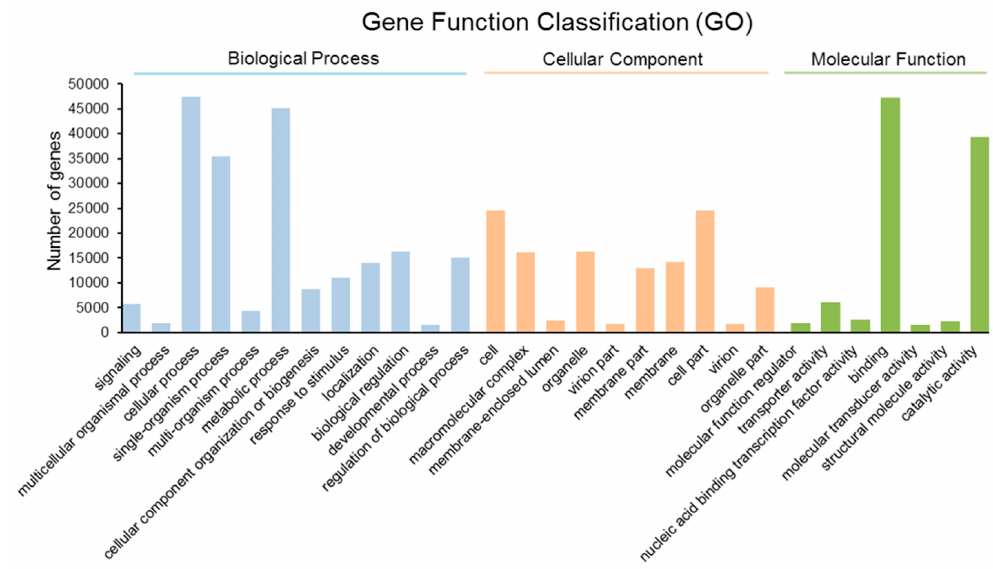
Figure 2. Gene ontology classification of the T. foenum-graecum unigenes.